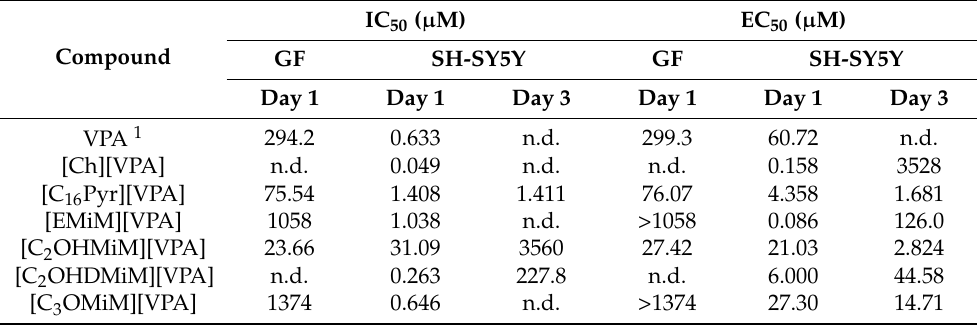
Table 2. Antitumor activity (IC 50 and EC 50 ) of the prepared formulations in the neoplastic human tumor cell line SH-SY5Y on days 1 and 3, as well as non-neoplastic Gingival Fibroblasts on day